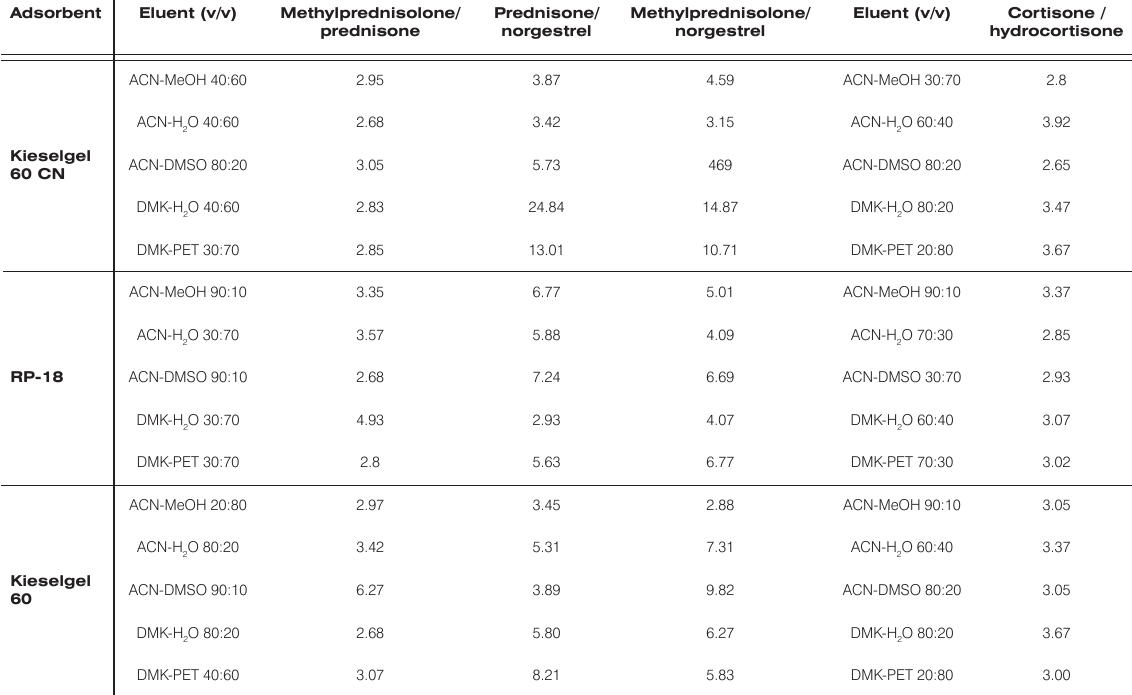
Table 3. The highest values of the parameter Δ ( Δ G o ) for prednisone, methylprednisolone, norgestrel and for cortisone and hydrocortisone, using different mobile phases (v/v). Adsorbent Eluent (v/v) Methylprednisolone/ Prednisone/ Methylprednisolone/ Eluent (v/v) Cortisone / prednisone norgestrel norgestrel